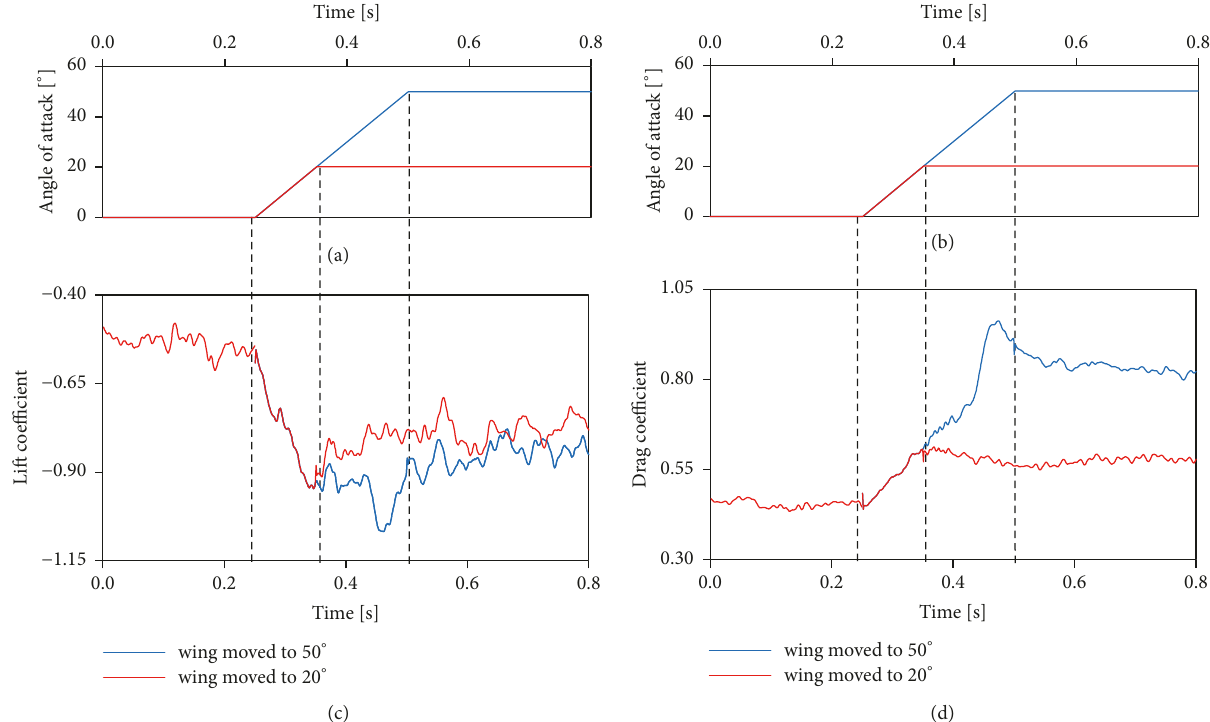
Figure 11: (a), (b) Plots of the rear wing’s angle of attack. (c) The characteristics of the lift coefficient over time. (d) The characteristics of the drag coefficient over time.